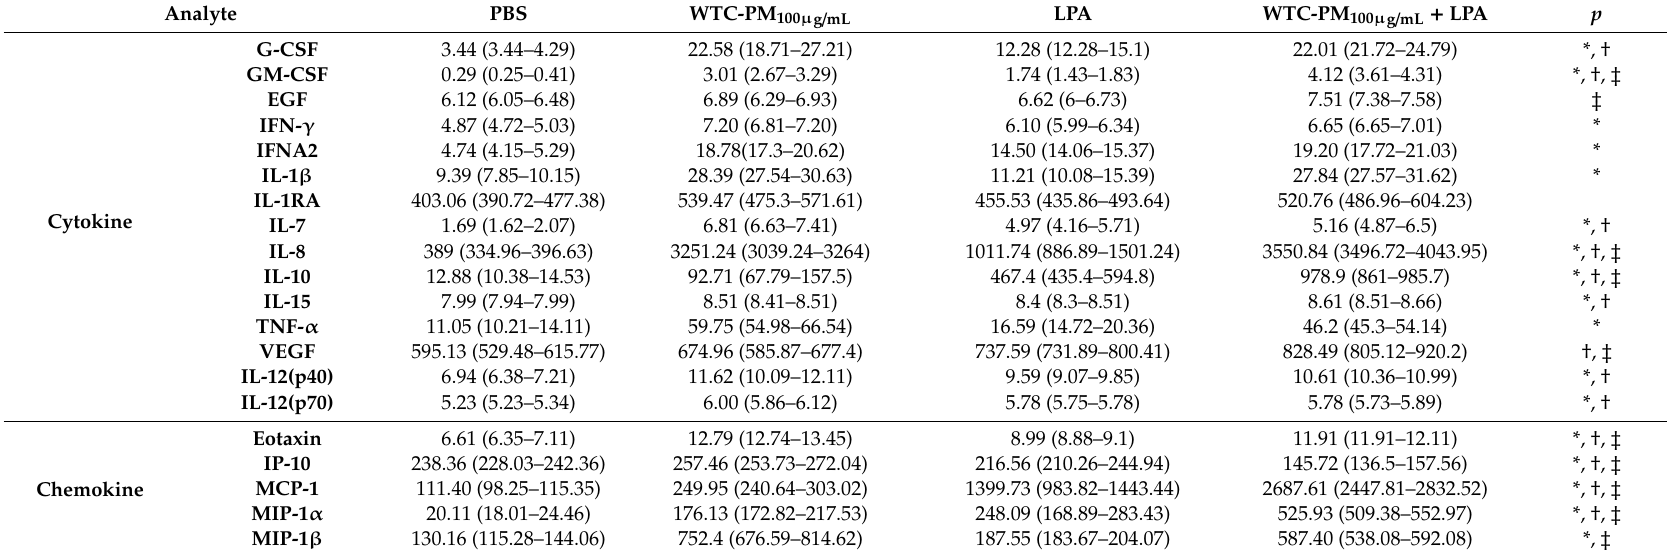
Table 1. Analyte Profile of THP-1-Derived